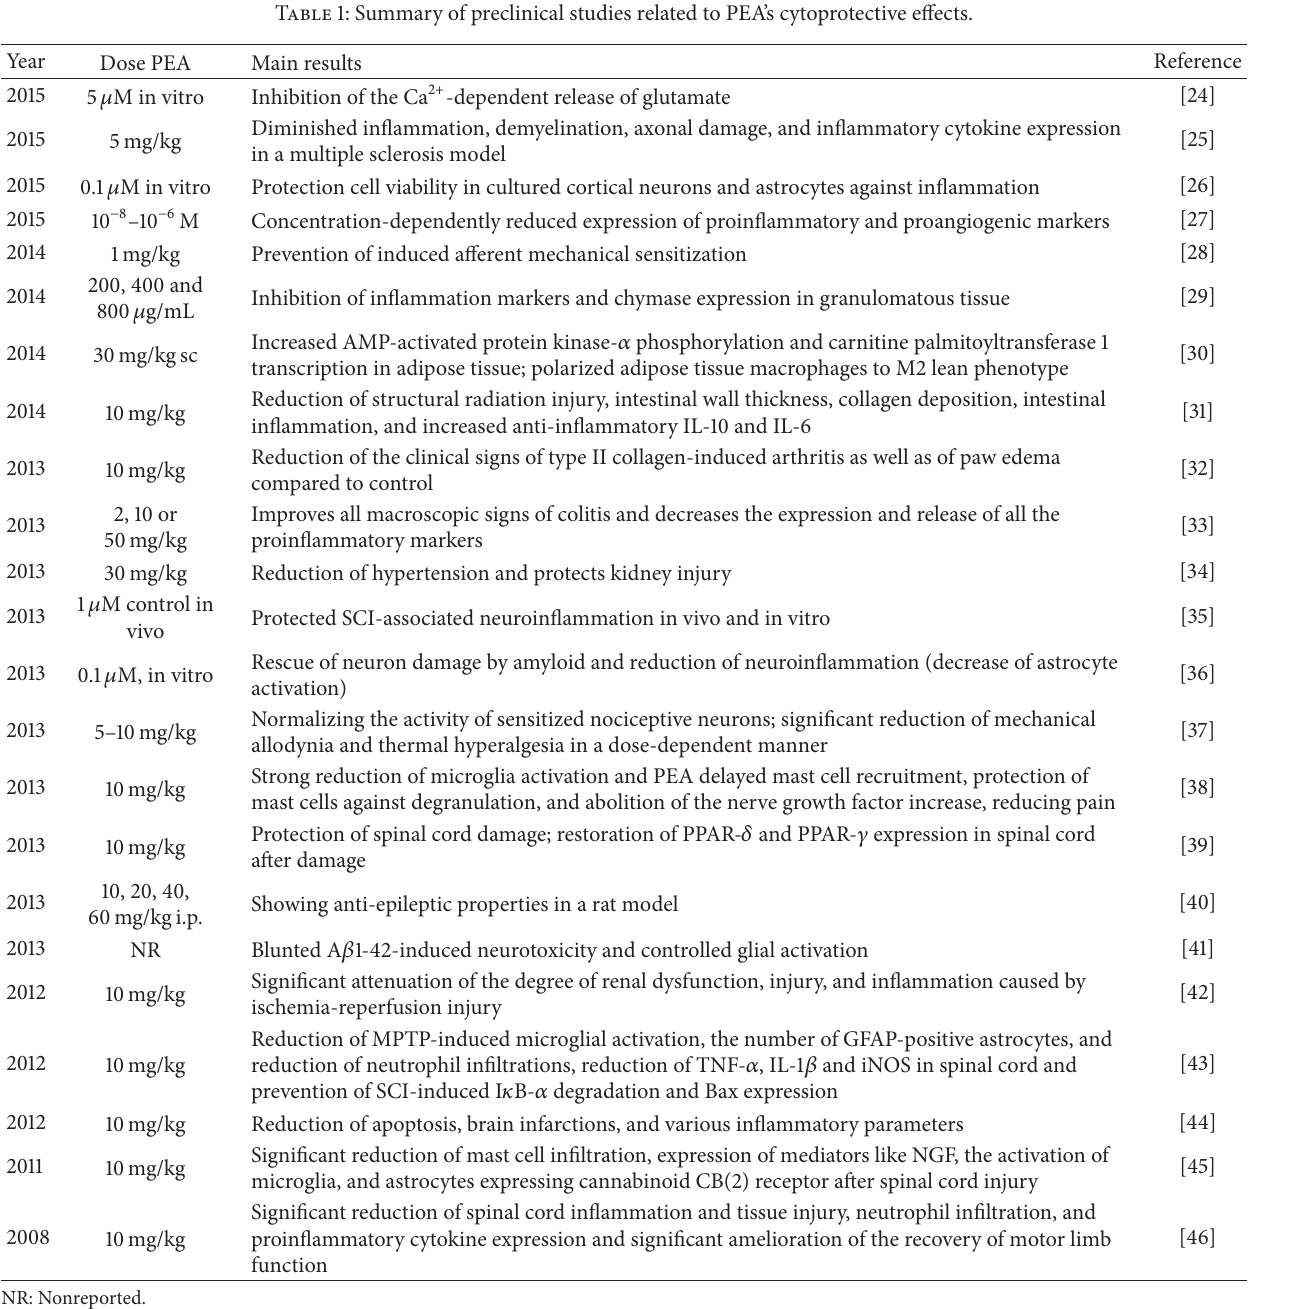
Table 1: Summary of preclinical studies related to PEA’s cytoprotective